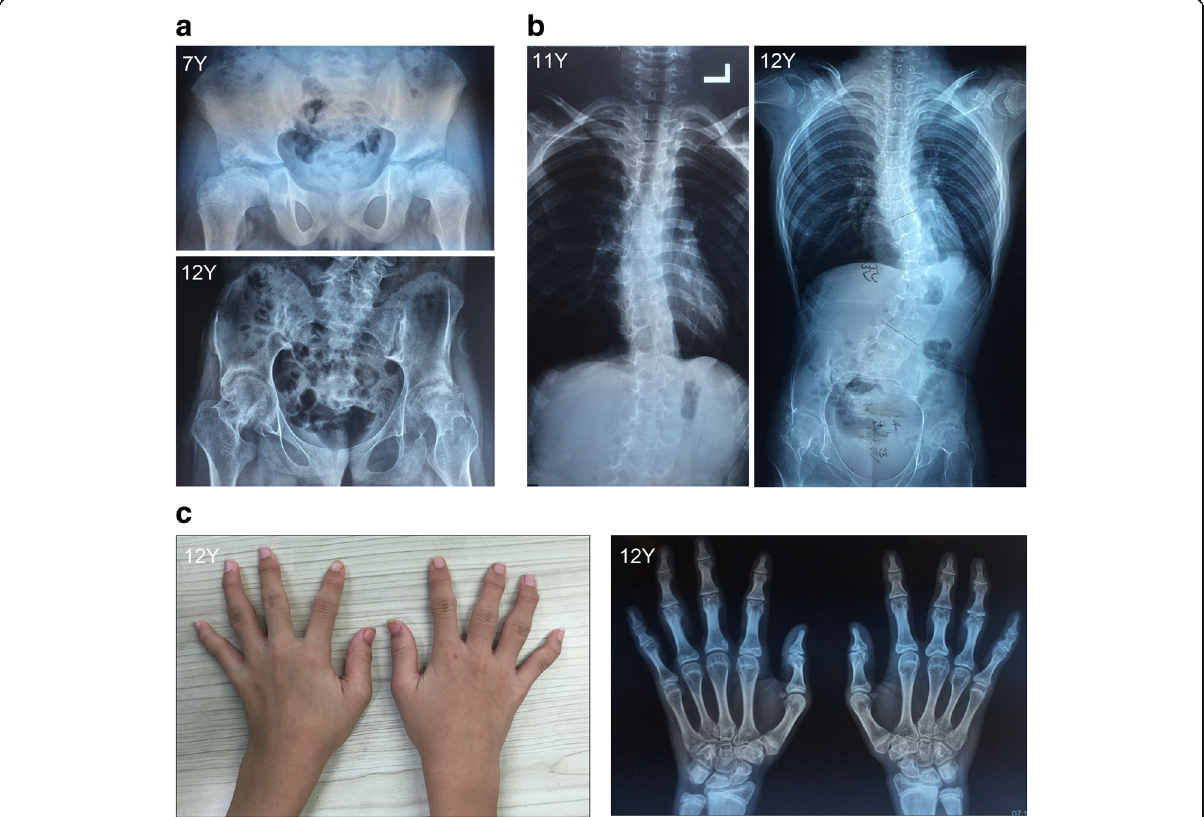
Fig. 1 Radiographs and clinical features of patient 1. Hip radiographs revealed coxa plana at the ages of 7 and 12 years ( a ). Spinal radiographs confirmed the progress of scoliosis ( b ). Hand radiographs confirmed the brachydactyly and significantly flattened articular surface ( c – d